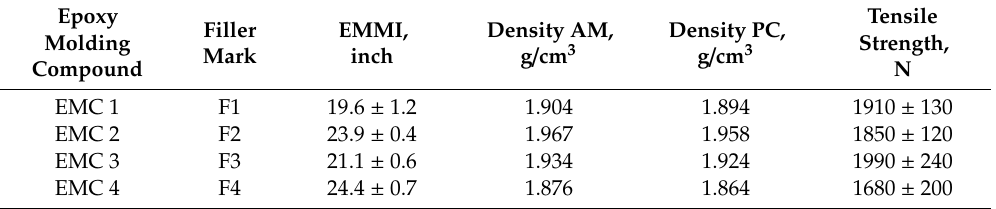
Table 5. Physical and mechanical properties of tested EMCs granulates and final test